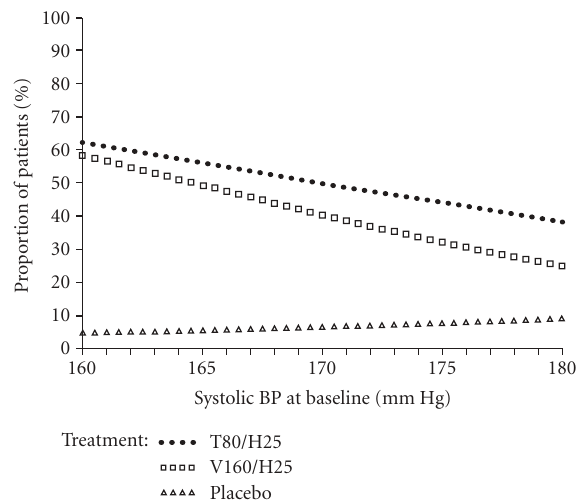
Figure 2: Proportion of patients achieving BP goal ( < 140 /90mmHg), per treatment group, according to SBP at base- line (results from a logistic regression model allowing for treatment-by-baseline SBP interaction). T80/H25: telmisartan 80mg/hydrochlorothiazide 25mg. V160/H25:valsartan 160mg/ hydrochlorothiazide 25mg.